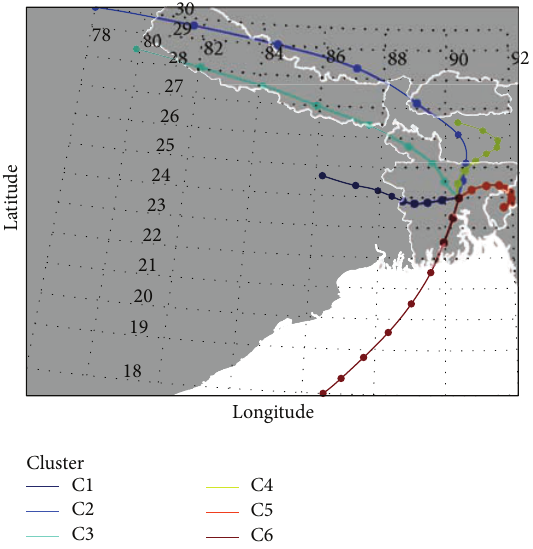
Figure 3: 6-cluster solution to back trajectories calculated for Gazipur site during dry season of 2014, showing the mean trajectory for each